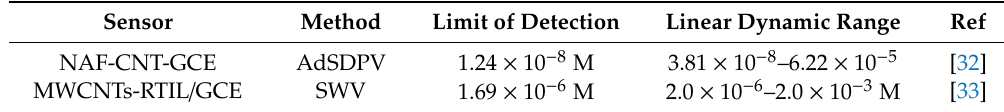
Table 2. Many characteristics of the GCE in VEN electrochemical